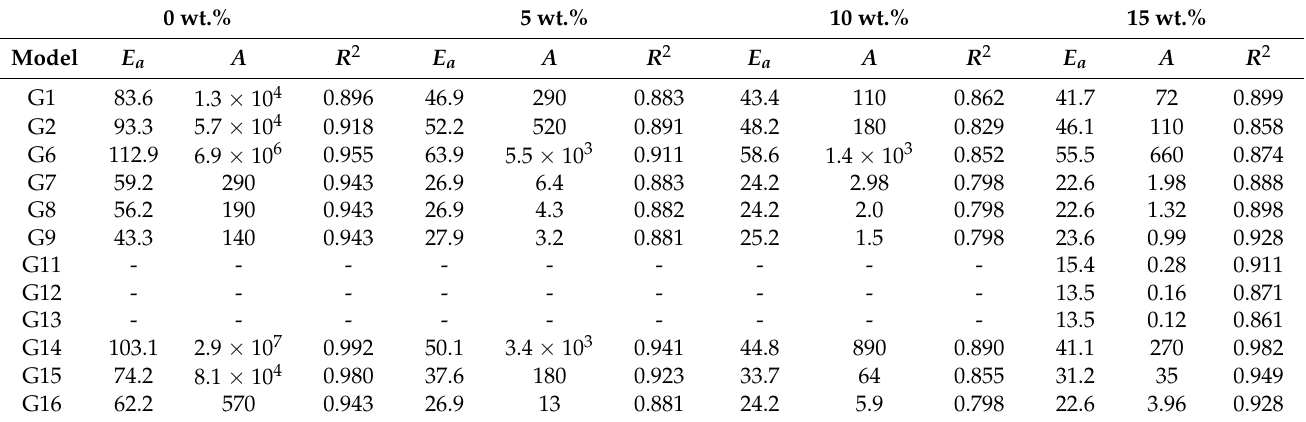
Figure 6. E a from the most fitting reaction models of CO 2 gasification at different dolomite loadings. Table 5. Kinetic parameters obtained by CR for the CO 2 gasification of Subcoal™ PAF at different dolomite